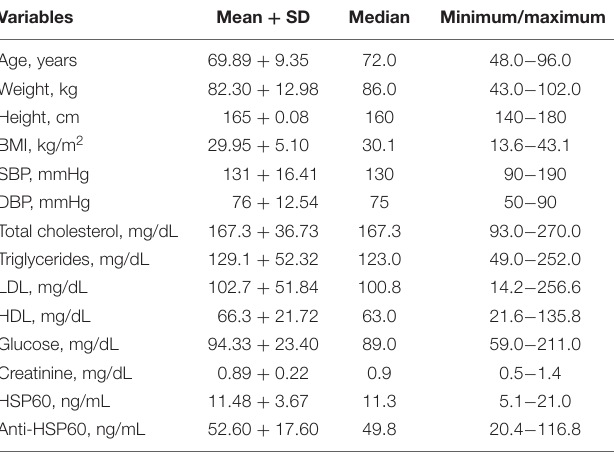
TABLE 1 | Clinical and anthropometric characteristics of the 57 study participants.